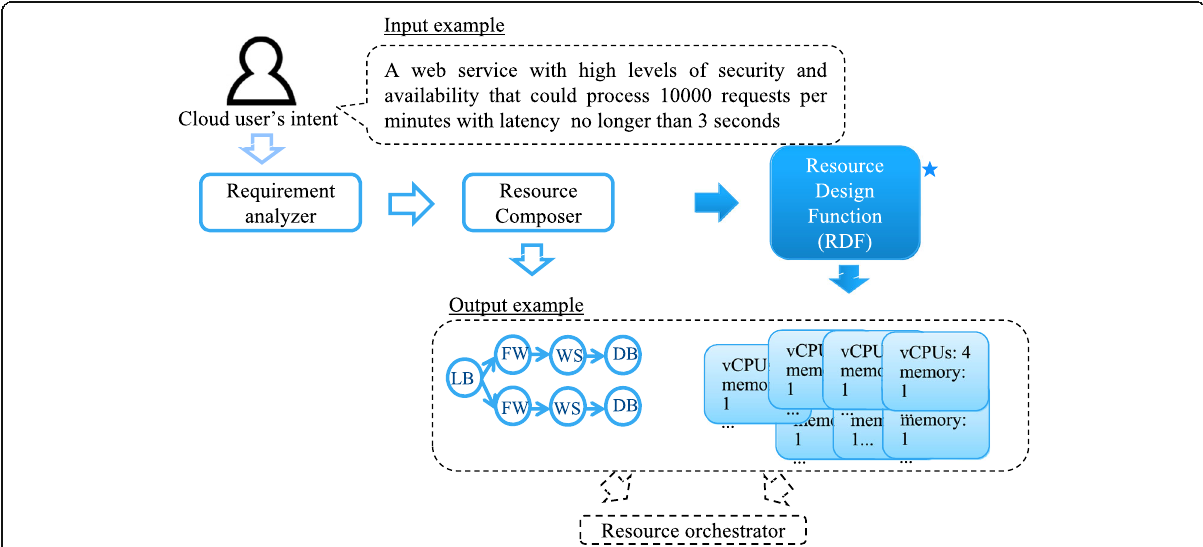
Fig. 2 Overview of Intent-based Cloud Management framework & example of input and output of ICSM. LB: Load Balancer FW: Firewall WS: Web Server DB: